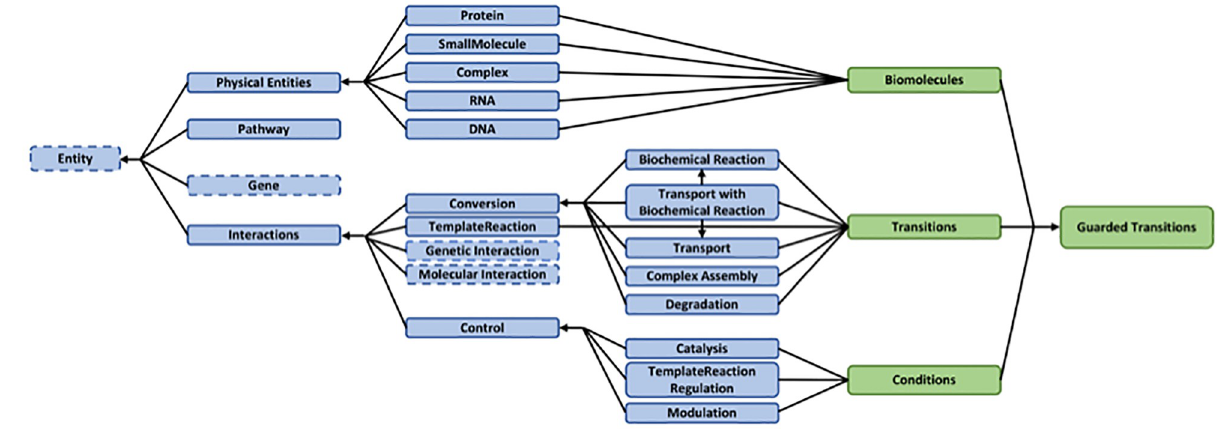
Fig 1. Conversion of BioPAX classes into guarded transitions. BioPAX classes (in blue) denoting cellular and molecular objects in biological pathways are interpreted as Cadbiom entities, transitions and conditions (in green). Unused BioPAX classes are surrounded by dashes.